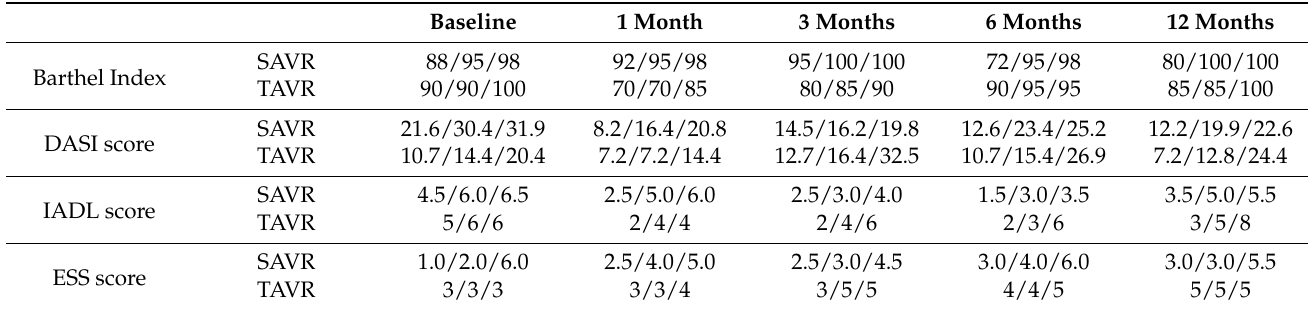
Table 2. Baseline characteristics according to the type of intervention. Data are reported for that underwent SAVR (3 patients) and TAVR (5 patients).